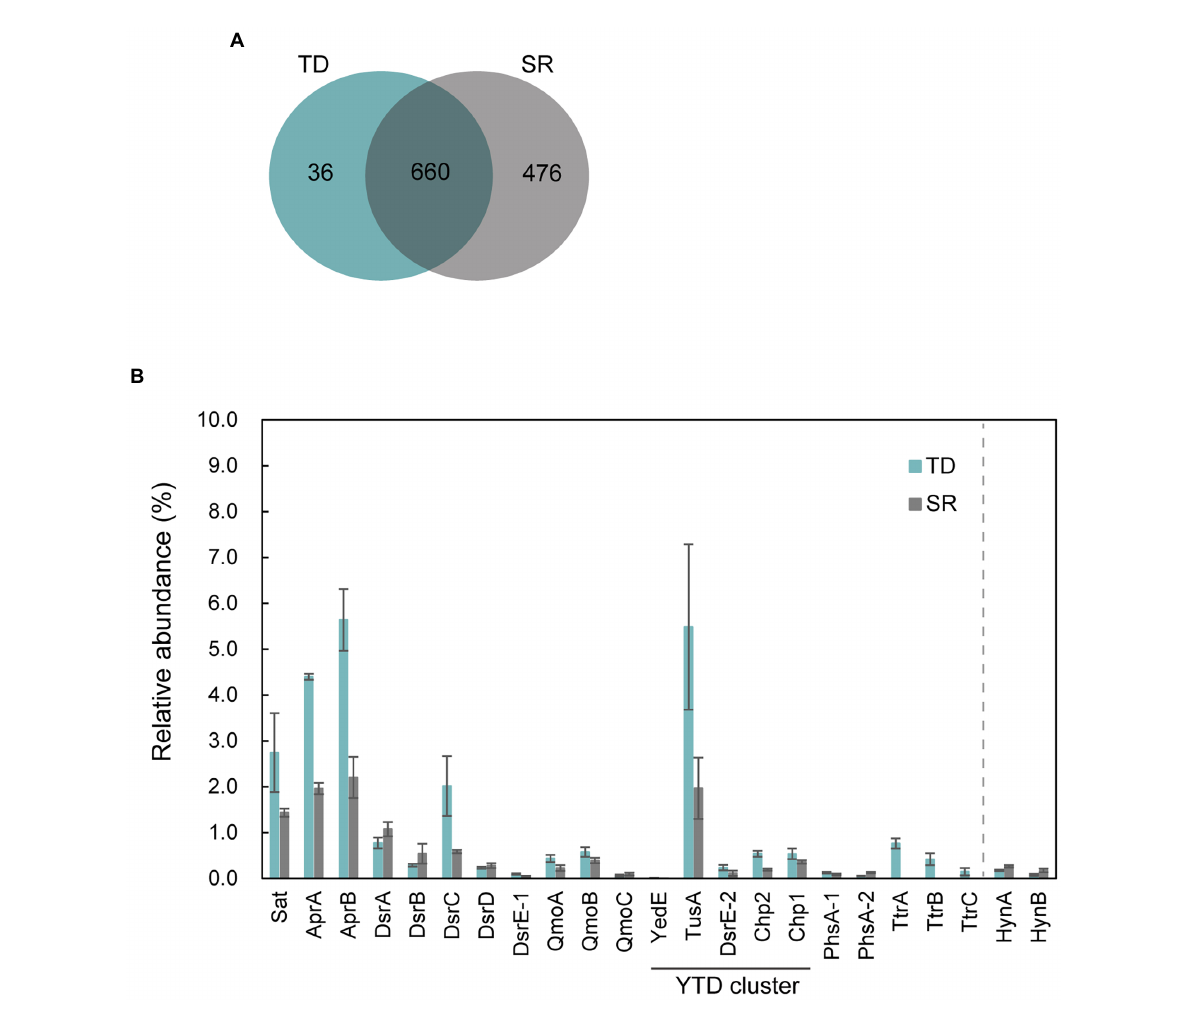
FIGURE 4 Proteomic profiles of strain GF1 T under thiosulfate disproportionation (TD) and sulfate reduction (SR). (A) Venn diagram of shared/unique proteins identified in the proteome of TD (Blue) and SR (Gray). (B) Relative abundance (%) of proteins potentially involved in sulfur metabolism found in the proteome of strain GF1 T under TD (Blue) and SR (Gray). Relative abundance is based on the average NSAF values of the biological triplicates. Error bars represent standard error of the biological triplicates. HynA/B is shown for comparison. The locus tag for each protein is listed in Supplementary Table